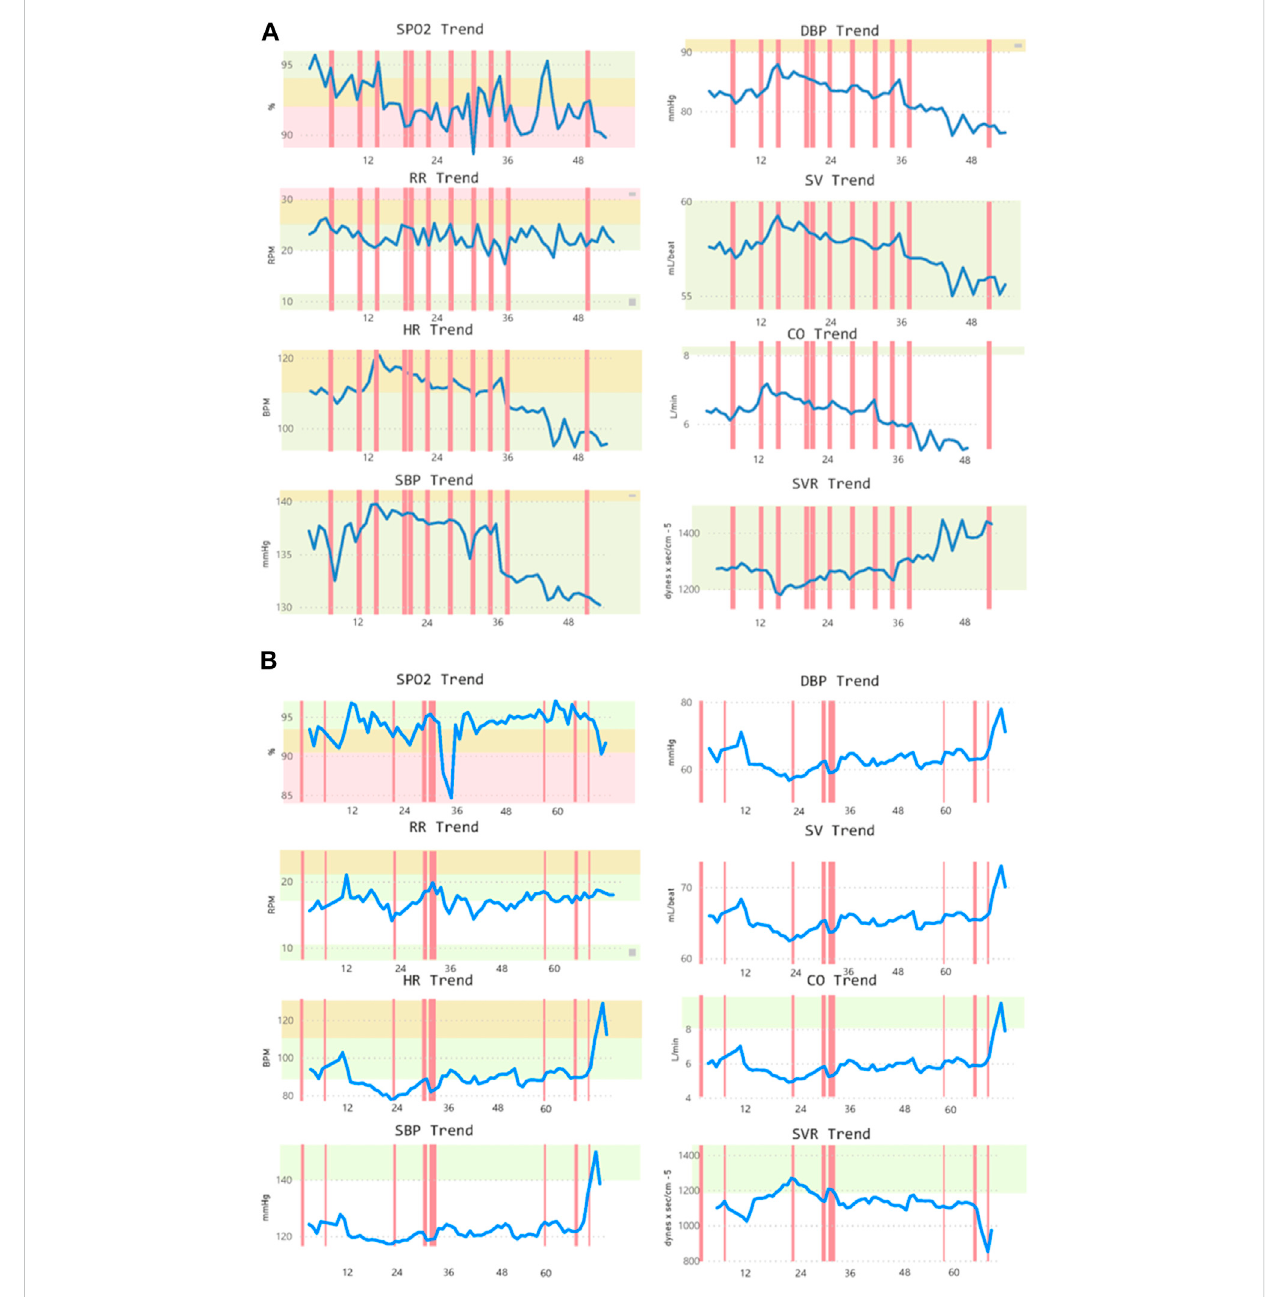
FIGURE 6 Two samples of admitted patients with (A) terminal cancer and (B) sepsis. In both samples, alerts are shown based on the new detection tool. CO, cardiac output; DBP,diastolicblood pressure;HR,heartrate;RR,respiratoryrate;SBP,systolicblood pressure;SpO 2 ,bloodoxygen saturation;SV,stroke volume; SVR, systemic vascular